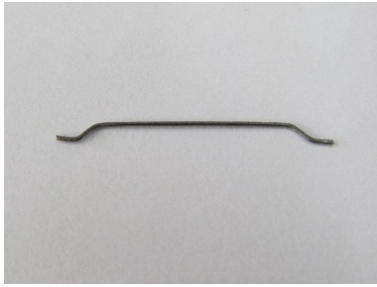
Figure 1. Shape of a hooked ‐ end steel fiber. Table 2. Mixture proportions of OPC and AAS concretes.